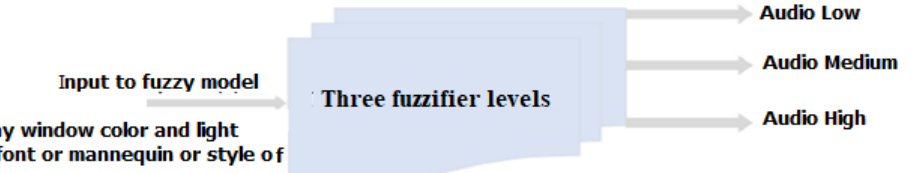
Figure 11. Triangular membership function for fuzzy system inputs and outputs.